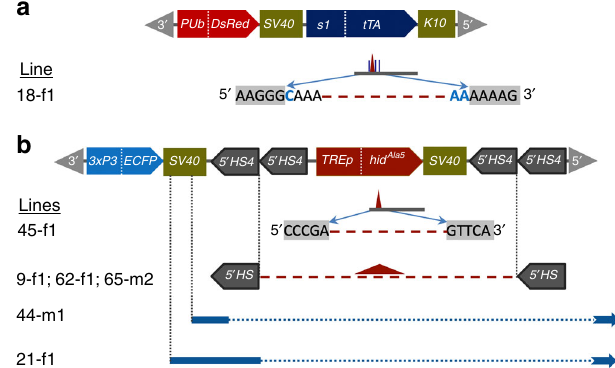
Fig. 2 Genetic alterations in the tTA driver and lethal effector vectors in primary-site lethal revertant survivor lines. a Line 18-f1 has a 27-bp deletion and 3 nucleotide substitutions (blue vertical lines and nucleotides) in the tTA gene and b line 45-f1 has a 26-bp deletion in the hid Ala5 cell death gene (maroon dashes and triangles indicate deleted sequences). Lines 9-f1, 62-f1, and 65-m2 have identical deletions of the TREp-hid Ala5 lethal effector and two 5 ’ HS4 insulator sequences, lines 44-m1 and 21-f1 exhibit deletions (blue dotted lines), and insert sequences (blue solid lines) from within the ECFP -linked SV40 extending downstream through the 3 ’ genomic insertion site sequence (blue arrows indicate unknown indel termination